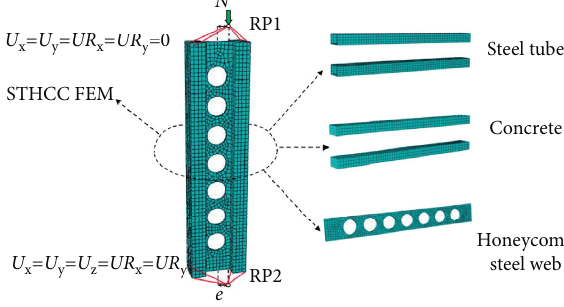
Figure 3: The FE models of